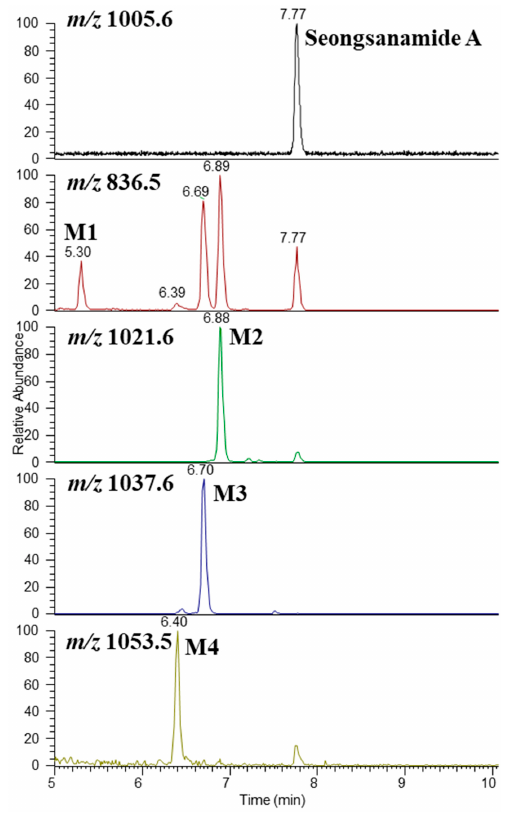
Figure 4. Representative selected-ion monitoring chromatogram of seongsanamide A and its four metabolites (M1–M4) obtained from the liquid chromatography-high resolution mass spectrometry analysis of human liver microsomes.